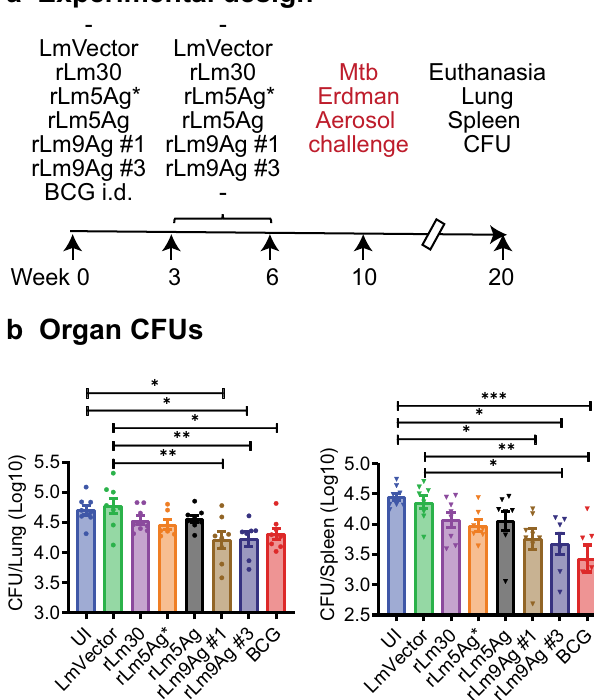
Fig. 7 Ef fi cacy of immunization with rLm5Ag and rLm9Ag vaccines against Mtb aerosol challenge in C57BL/6 mice. a C57BL/6 mice ( n = 8/ group) were unimmunized (UI), vaccinated i.d. with 5 × 10 5 CFU BCG at Week 0, or vaccinated s.q. three times with LmVector, rLm30, rLm5Ag* (rLm30 + rLm4Ag), rLm5Ag (a single vaccine expressing the same 5 Mtb antigens as rLm5Ag*), or rLm9Ag (clones #1 and #3) at Weeks 0, 3, and 6. The mice were then challenged at Week 10 with aerosolized Mtb Erdman strain (average of 10 CFU delivered to the lungs of each animal, as assayed at Day 1 post challenge) and euthanized at Week 20. b Afterwards, lungs (left) and spleens (right) were removed and assayed for bacillus burdens. Shown are means ± SEM. Each symbol represents one mouse. * P < 0.05; ** P < 0.01; and *** P < 0.001 by one-way ANOVA with Tukey ’ s multiple comparisons test (Prism 9.2.0). A similar experiment was repeated in BALB/c and P < 0.01), comparable (difference not statistically signi fi cant)